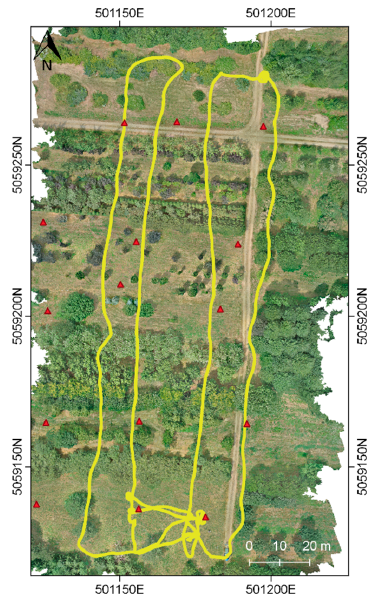
Figure 3. Flight tracks (yellow lines) for the RGB summer survey and positions (red triangles) of the 15 b/w targets for the GNSS survey.